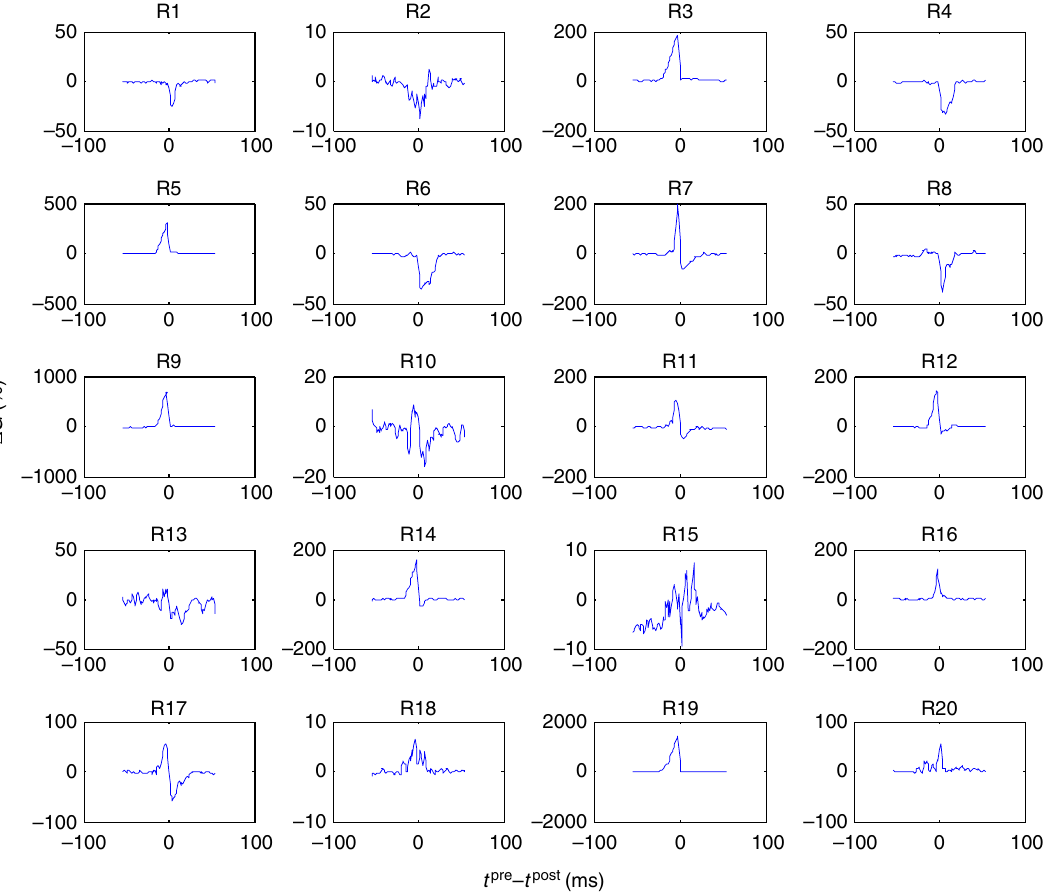
Fig. 8 STDP variations. Measured STDP device-to-device variations for 20 memristors. The vertical axis shows the relative change in the conductance for a particular time difference between pre and post-synaptic spikes. (Note the different vertical axis scale for the panels.) The top label shows the device index, counted from the top of the crossbar circuit. Similar to ref. 12 , the device conductance was always tuned to approximately 16 µ S before measuring each data